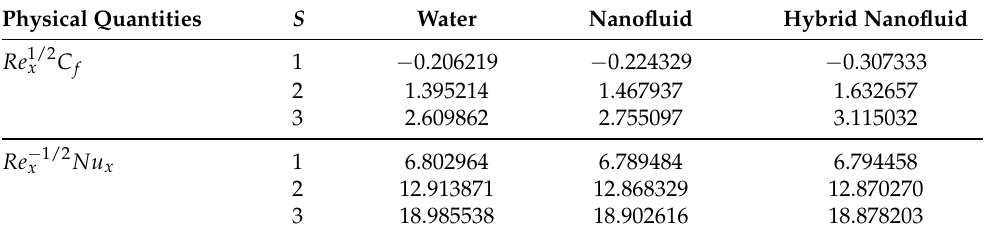
Table 6. Values of Re 1/2 x C f and Re − 1/2 x Nu x for S and several types of fluids when Rd = 1.0, λ = − 8.0 and Pr = 6.2.